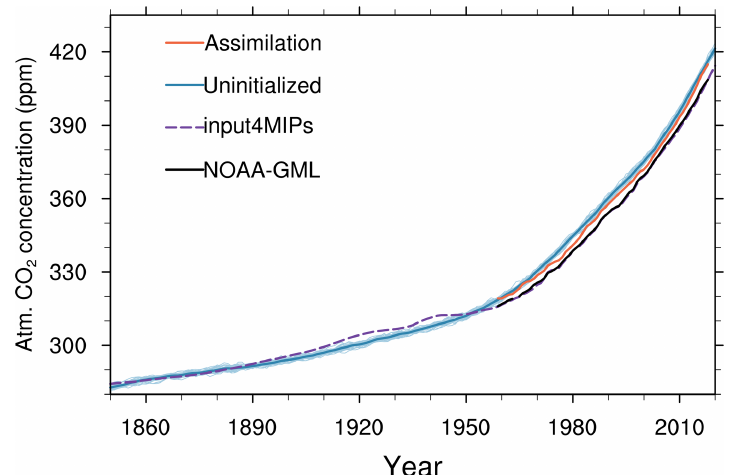
Figure A3. Time series of atmospheric CO 2 concentration from model simulations and observations from 1850 to 2020. The assimilation and uninitialized simulations are shown with solid orange and blue lines, respectively. The CMIP6 input4MIPs atmospheric CO 2 concentration forcing and the NOAA_GML observation (Dlugokencky and Tans, 2020) are shown with dashed blue lines and solid black lines, respectively.